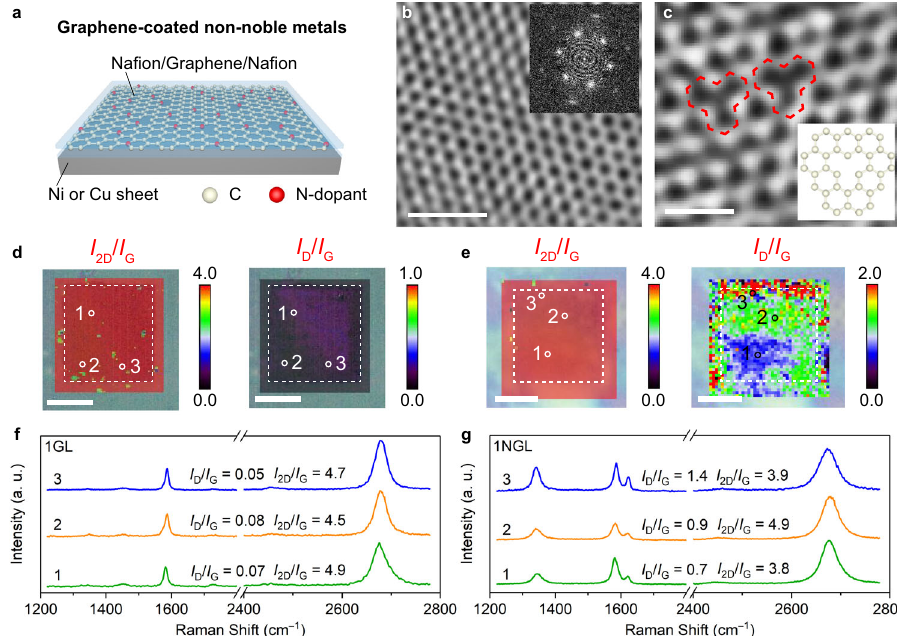
Fig. 1 Graphene-covered non-noble metal catalysts and graphene characterization. a Schematic diagram of a graphene-covered Cu or Ni sheet. HRTEM images of ( b ) 1GL and ( c ) 1NGL. Inset of ( b ): the corresponding fast Fourier transform (FFT) image. Inset of ( c ): the atomic model of the structural defect, highlighted by red marks. Raman maps of ( d ) 1GL and ( e ) 1NGL performed on a window-attached Si 3 N 4 chip. The dotted square indicates the window area. f , g Raman spectra were collected at the positions indicated on the corresponding maps. The I 2D / I G values provide evidence that monolayer graphene dominates. Scale bars: ( b ) 1 nm; ( c ) 0.5 nm; ( d , e ) 5 μ